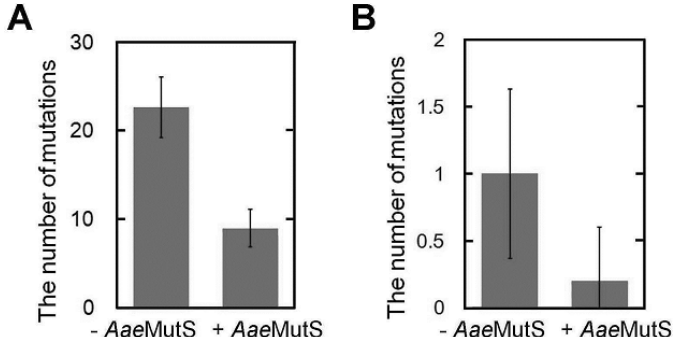
Figure 11. Aae MutS suppressed DNA polymerase-generated mutations during PCR. ( A ) The same experiment as in Figure 8A was performed using 0.3 μ M Aae MutS; ( B ) The same experiment as in Figure 8C was performed using Aae